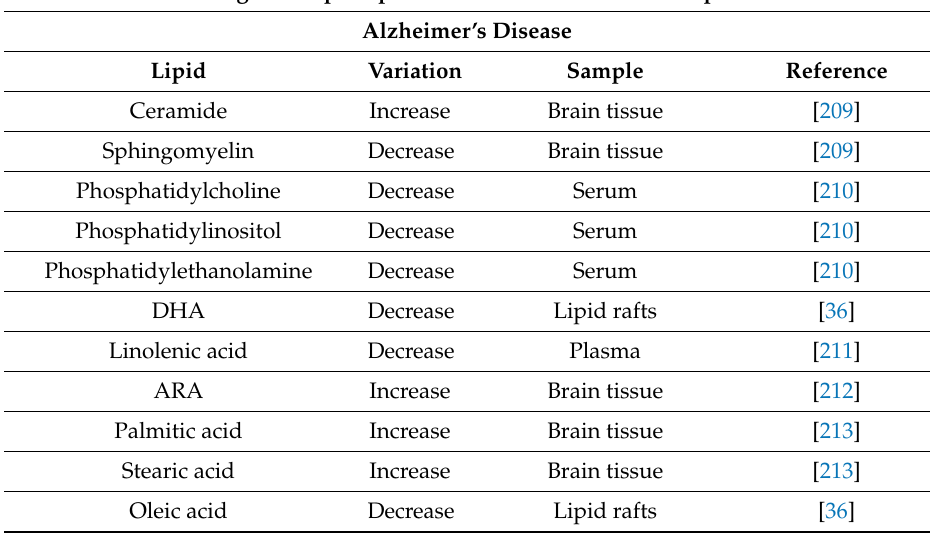
Table 1. Changes of lipid species in human bran and peripheral fluids under Alzheimer’s disease or Parkinson’s